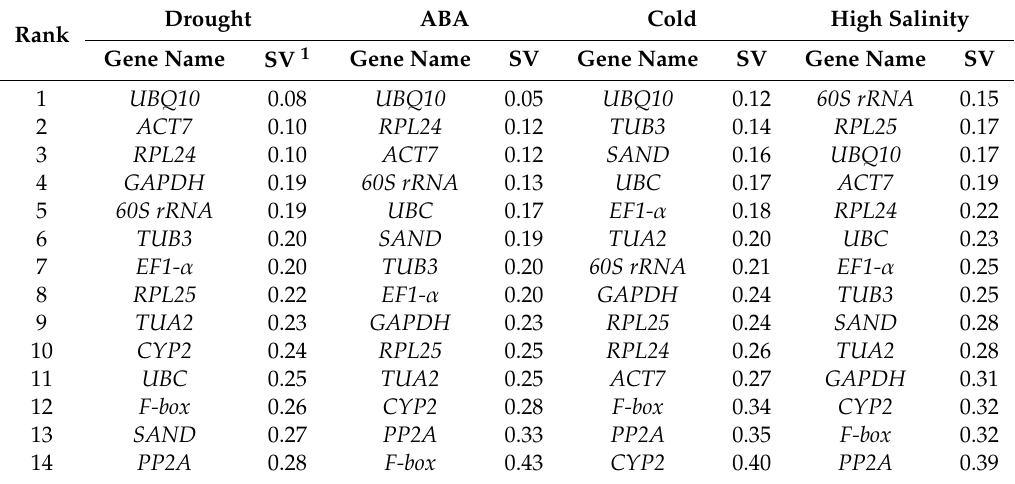
Table 3. Expression stability of candidate reference genes calculated by